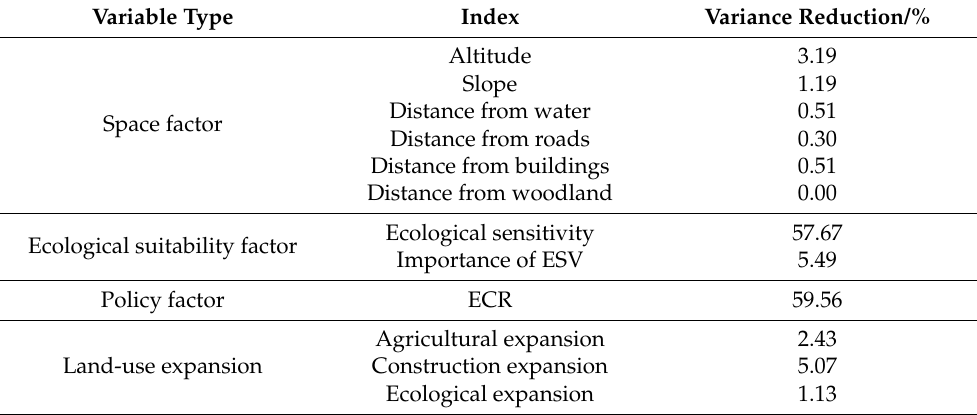
Table 3. Sensitivity analysis